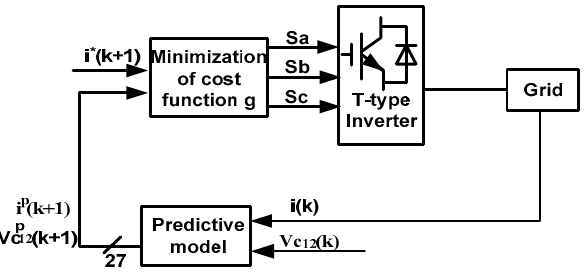
Figure 7. T-type inverter predictive current control method.